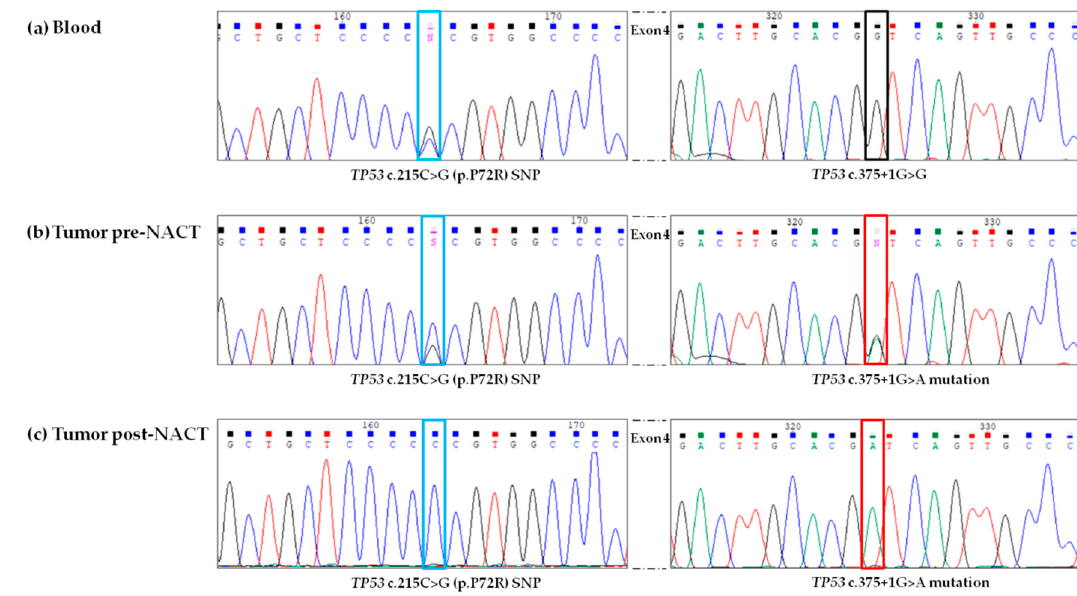
Figure 3. Confirmatory Sanger electropherograms of TP53 variants identified by NGS in a patient with HGSOC, in tumor samples collected at D-LPS (pre-NACT) and at IDS (post-NACT), and in reference (germline) blood sample. ( a ) Sequencing result in the reference blood sample showing